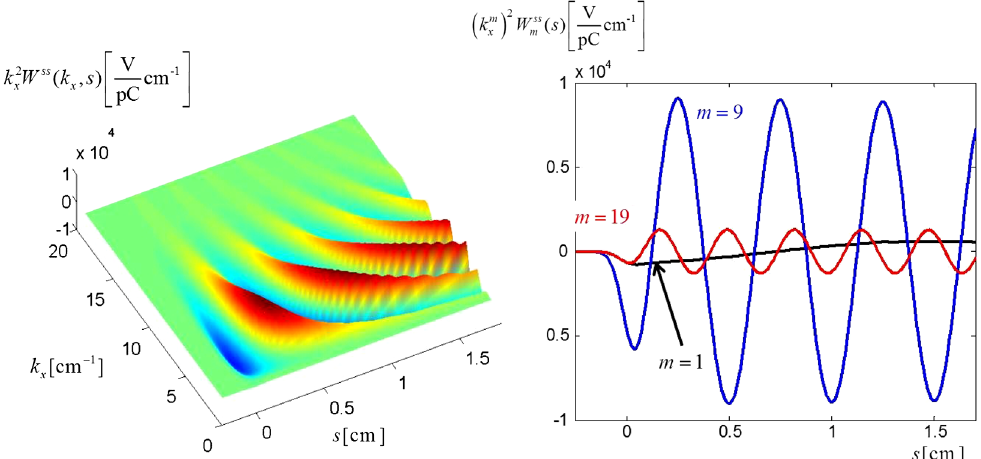
harmonics.FIG. FIG. 9. Longitudinal wake potential (left) and dipole wake potential (right), calculated from first 15 odd